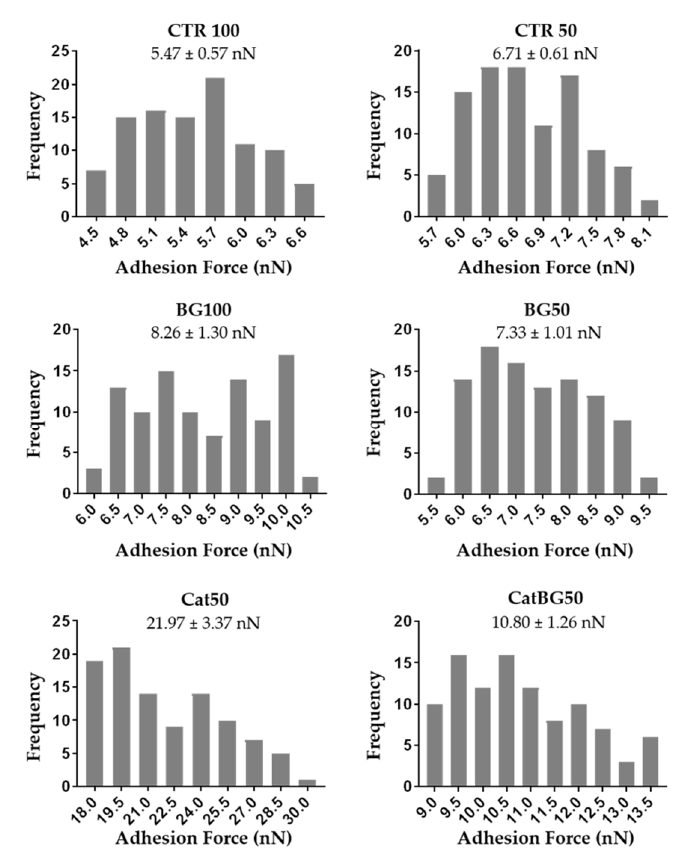
Figure A5. Representative force-distance (F-D) curves, where the adhesion force can be determined from the maximum of the adhesion value (in modulus) upon retraction of the surfaces. The JPK SPM Data Processor software (JPK Instruments, Berlin, Germany) was used to analyze the force curve and obtained the adhesion value.